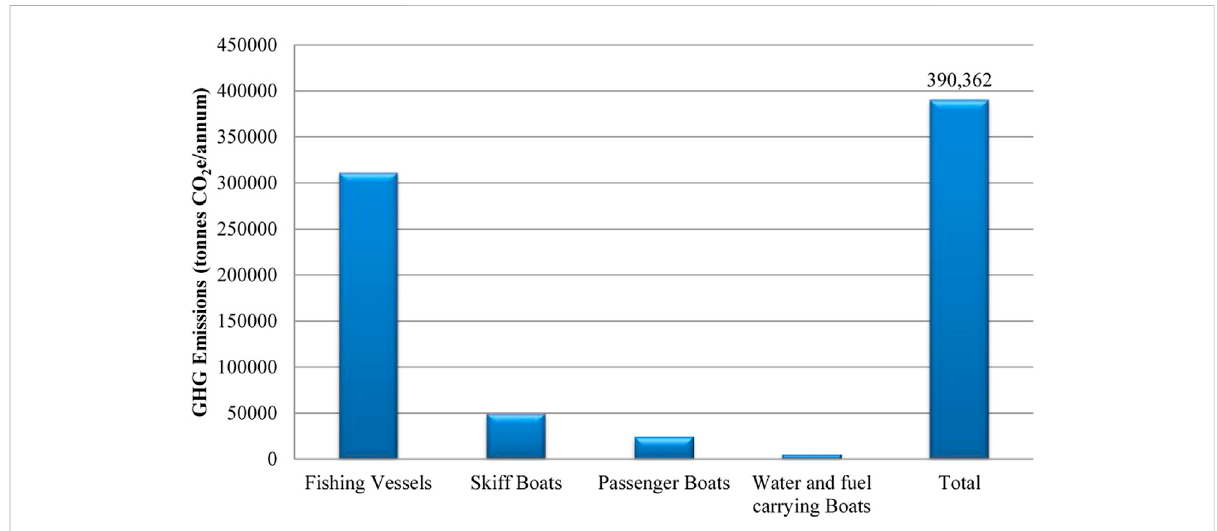
FIGURE 15 Total annual GHG emissions (CO 2 e) from fi shing and other crafts in Balochistan.